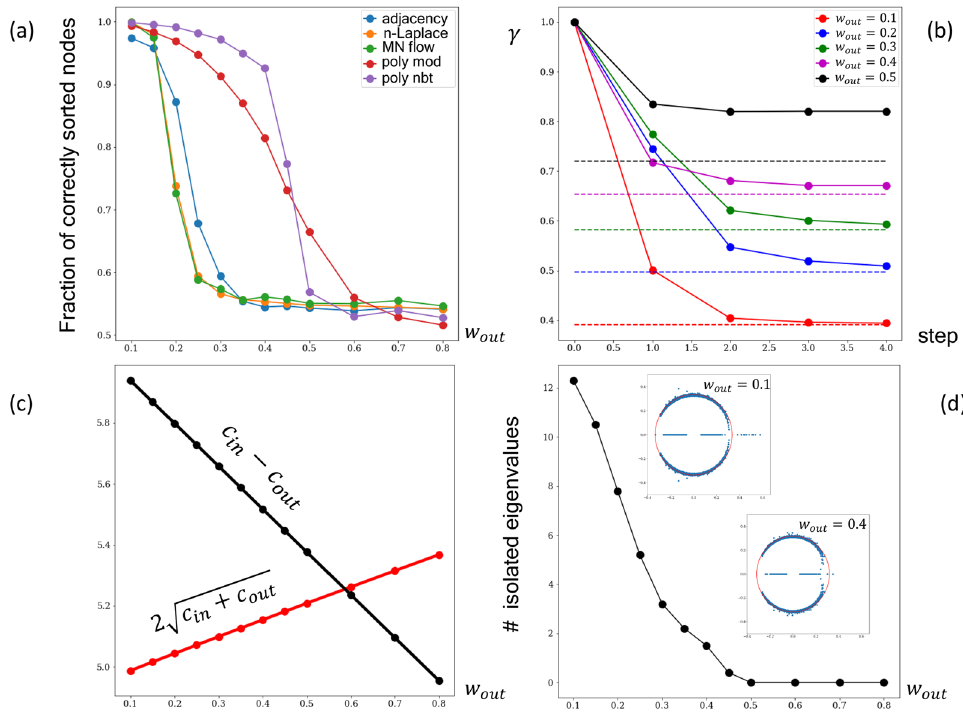
Figure 3. ( a ) Comparison of performance of different classical operators without background, polymer modularity and polymer non-backtracking flow operators ( N iterative approach that can be used to determine the optimal value of γ for five values of w out ; the true optimal values of γ calculated from (8) are shown by dash; ( c ) The mean numbers of inner c in and outer c out edges are calculated for each value of w out in order to estimate the detectability threshold for the corresponding regular network. ( d ) Amount of isolated eigenvalues of the polymer flow operator plotted against w out . Full spectra of the polymer flow operator for the two values of w out are shown in the